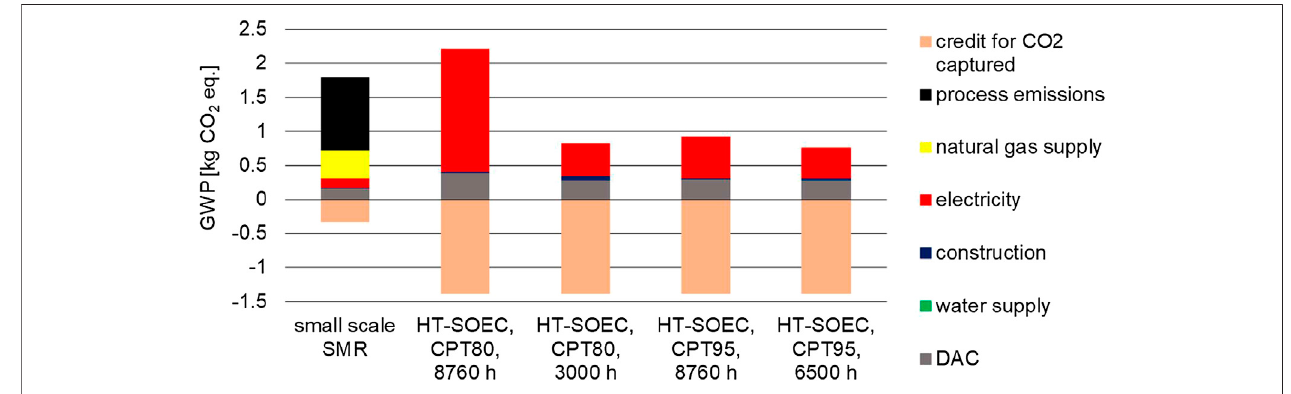
Frontiers in Energy Research |